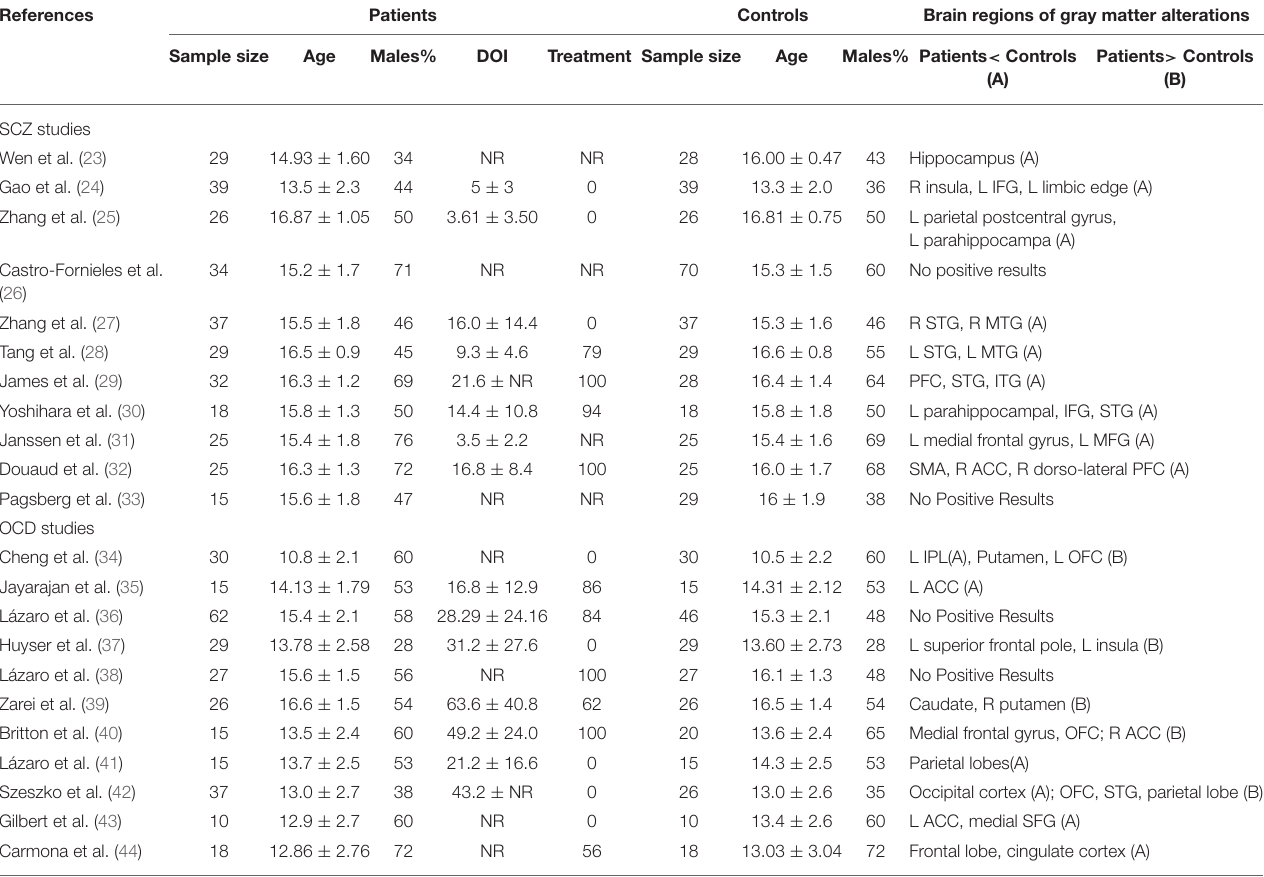
TABLE 1 | Demographic and clinical characteristics of the 22 voxel-based morphometry